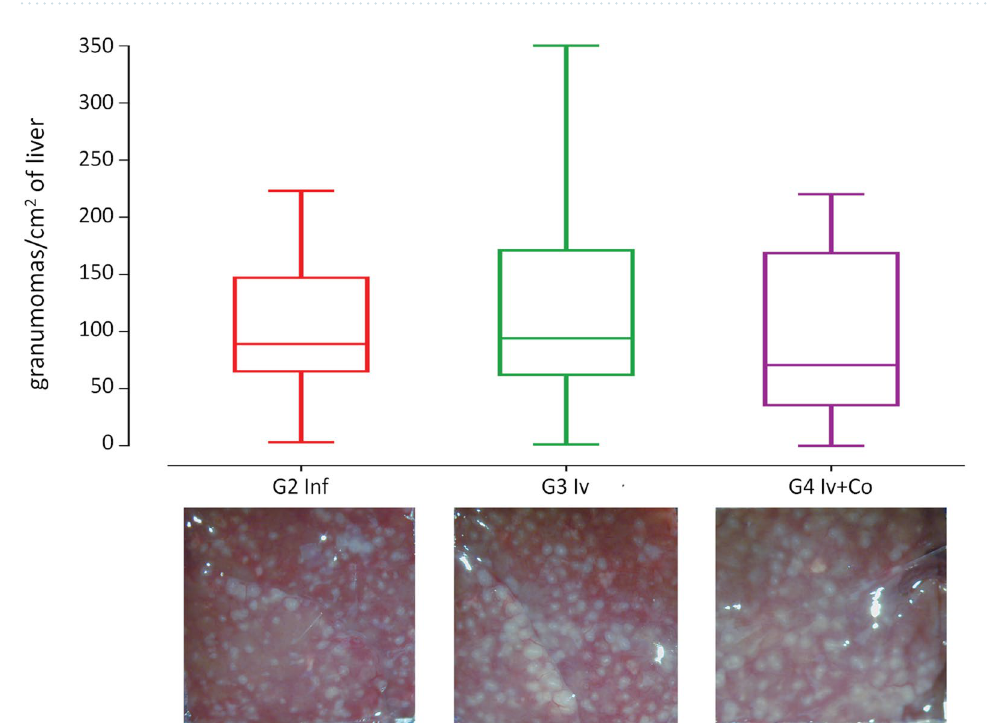
Figure 5. Granulomas in liver surface at the necropsy eight weeks post-infection of mice treated with ivermectin (Iv) or ivermectin and cobicistat (Iv + Co), infected with 150 cercariae of S. mansoni